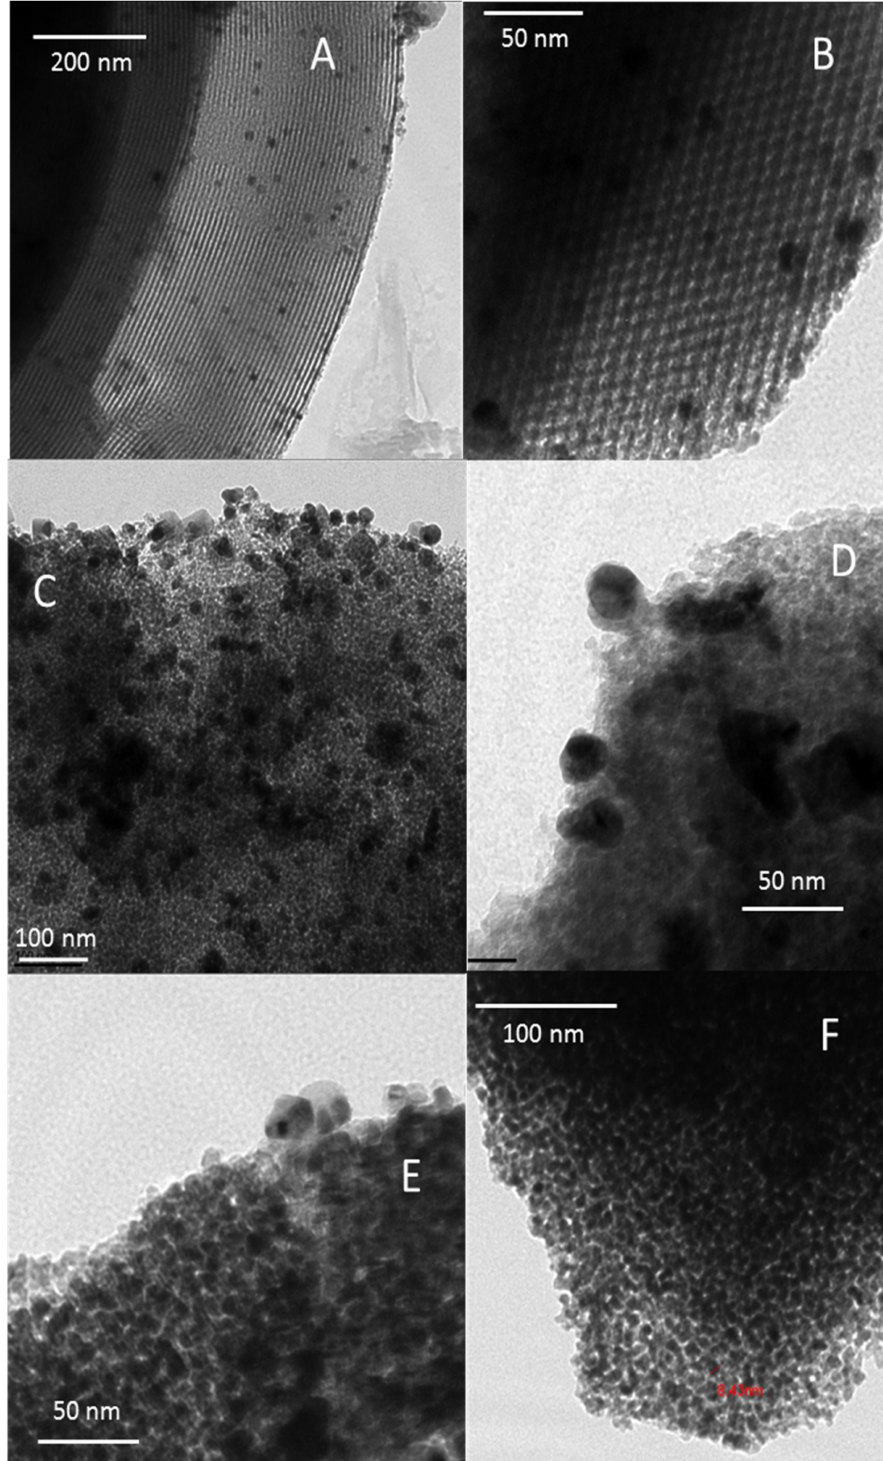
Figure 3. TEM micrographs of the calcined samples: 15.5 Ag/SBA-15-calc ( A , B ), 14.4 Ag/Al 2 O 3 -calc ( C , D ), 18.6 Ag/CeO 2 - calc ( E , F